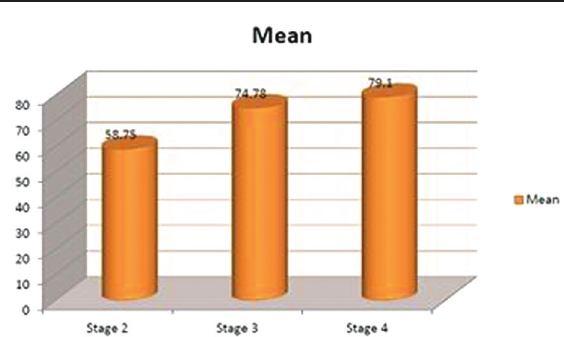
AECA, antiendothelial cell antibody; COPD, chronic obstructive pulmonary disease; FEV, forced expiratory volume; FVC, forced vital capacity; RVSP, right ventricular systolic pressure.